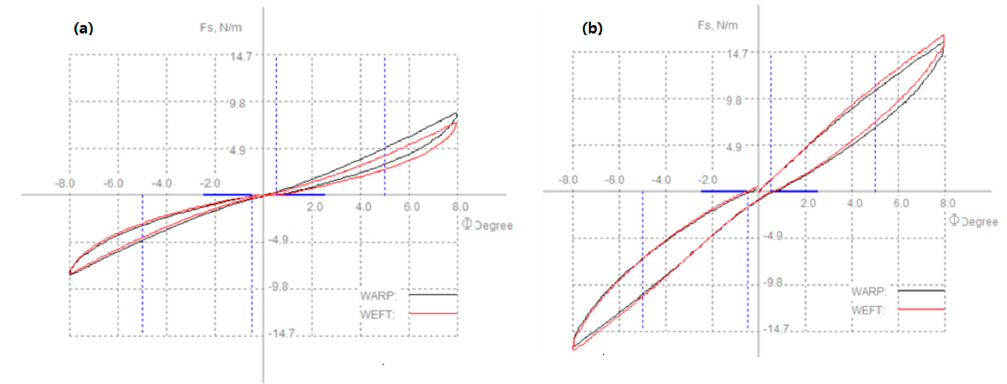
Figure 13. Shearing property of ( a ) woollen fabric; ( b ) woollen fabric with interlining.